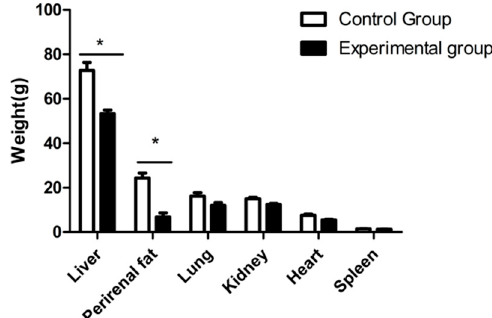
Figure 4. Weight changes of internal organs between the control and experimental groups. Values are presented as means ± SD. *, p < 0.05.